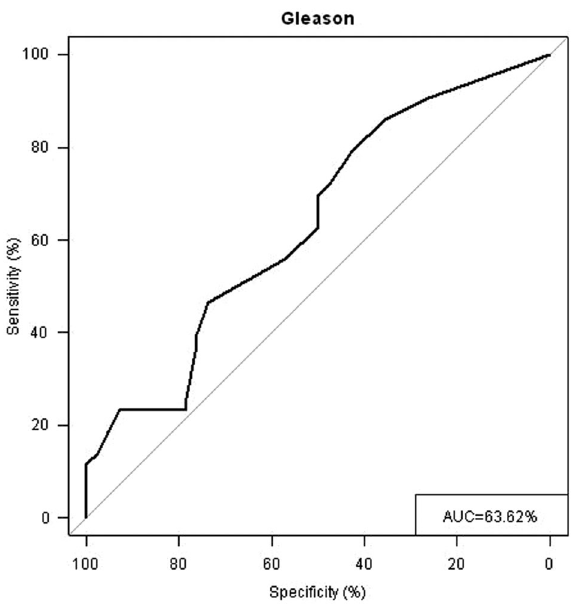
Figure 2. Receiver operating characteristic curve analysis for Gleason scores. AUC: area under the